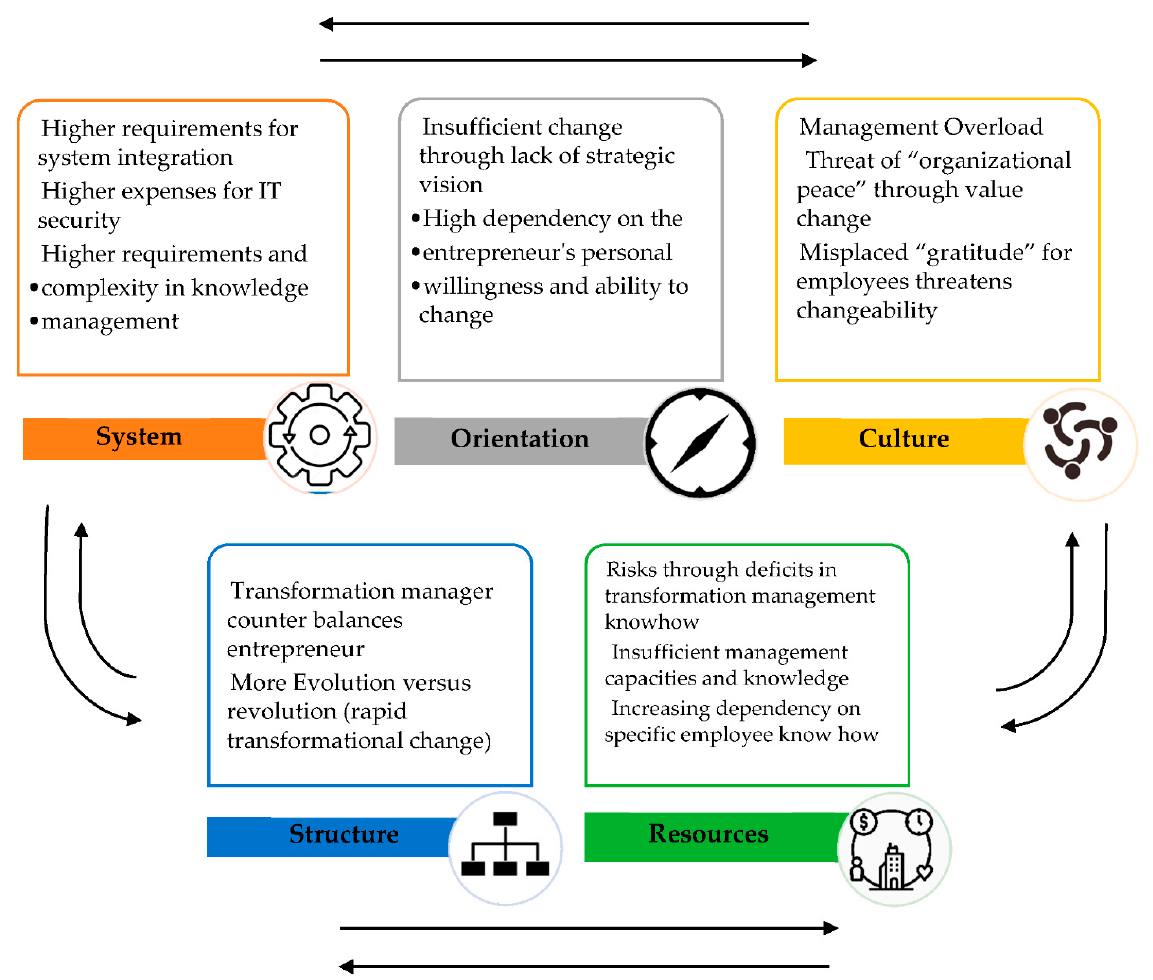
Figure 7. Challenges of the digitalization process in SMEs [21].